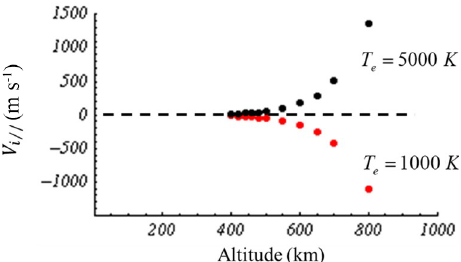
Figure 4. Steady-state parallel velocity in altitudes for ions (oxy- gen) produced by parallel electric fields: 0.4µVm − 1 ( T e = 1000K) in red dots and 2.0µVm − 1 ( T e = 5000K) in black dots. Vertical flows in altitudes from 400 to 800km are shown. Flow velocity is positive upward and negative